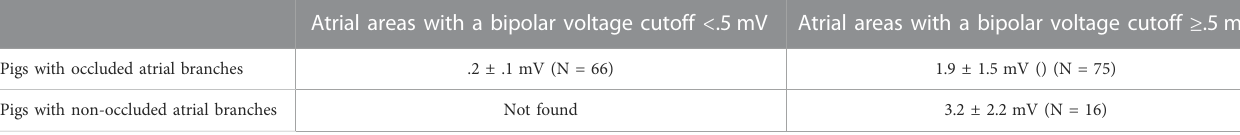
TABLE 1 Voltage of local left atrial bipolar electrograms in pigs with and without atrial coronary artery branch occlusion. Atrial areas with a bipolar voltage cutoff < .5 mV Atrial areas with a bipolar voltage cutoff ≥ .5 mV